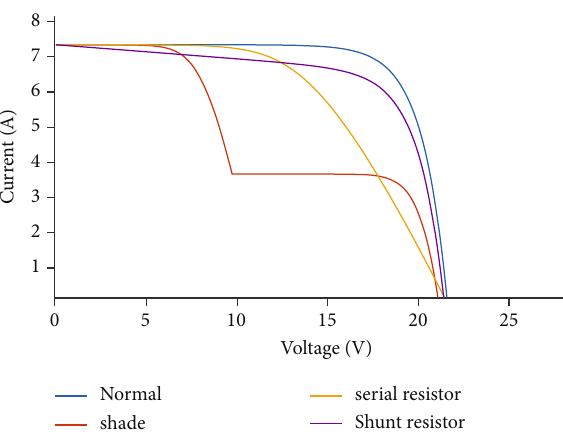
Figure 9: I-V characteristic of the di ff erent operating states.